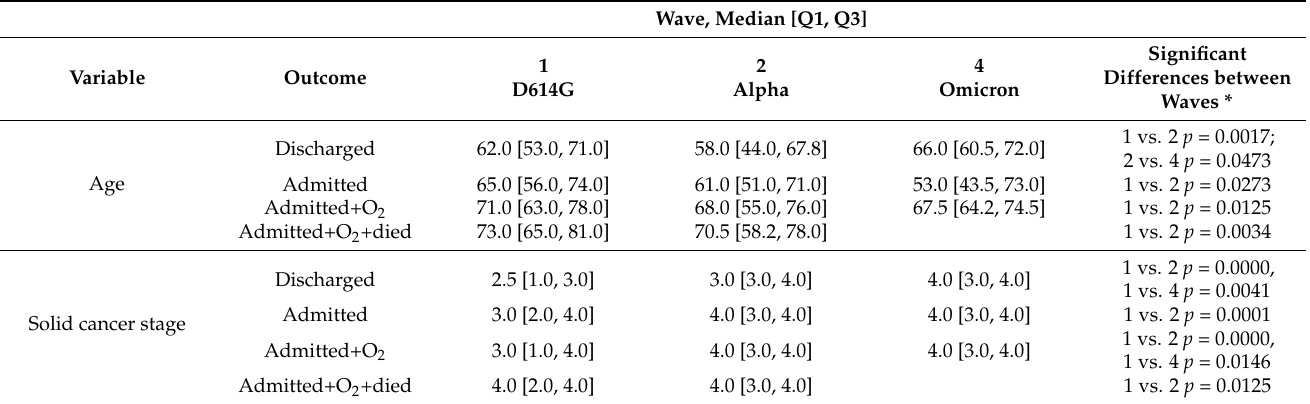
Table 4. Comparison of patients’ characteristics associated with severity of COVID-19 during waves, stratified by